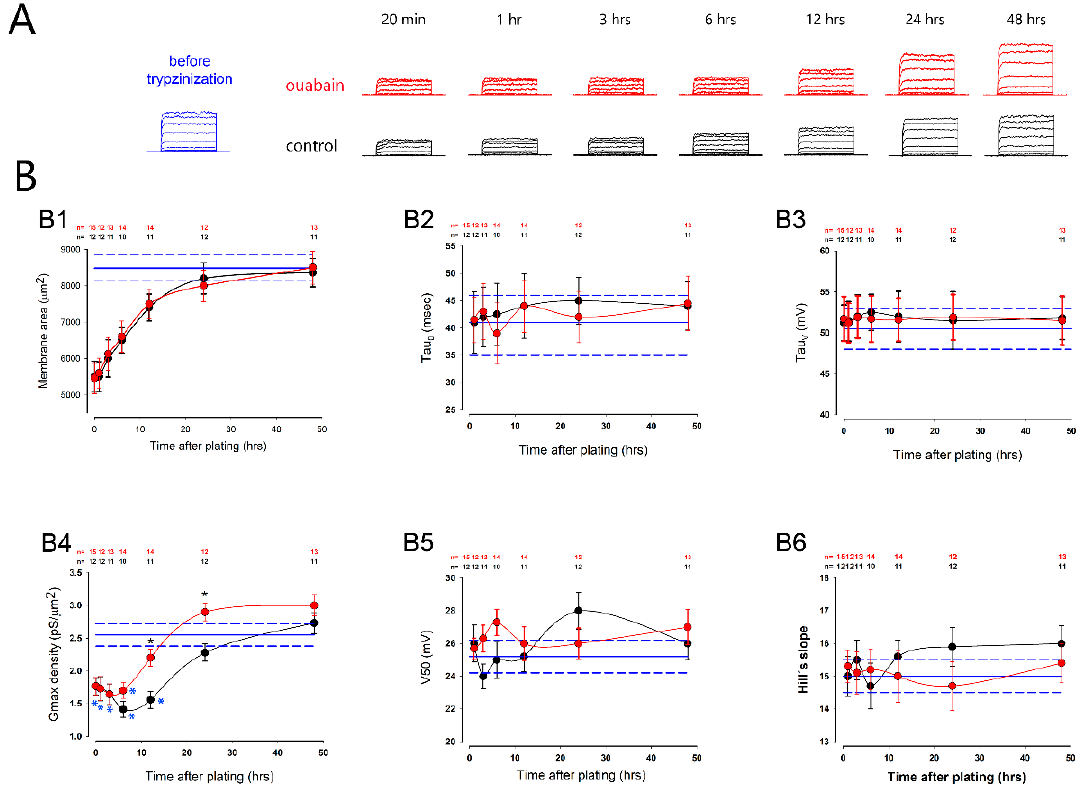
Figure 3. Ouabain accelerated the recovery of potassium currents after trypsinization. ( A ) The series of representative currents, recorded at different times after trypsinization and re-seeding at conflu- ence. At the top, in red, are shown the series of currents recorded from the cells treated with ouabain. At the bottom, in black, are shown the series of currents without treatment with ouabain. The series shown on the left in blue corresponds to a series of currents recorded from a cell in a mature mon- olayer, before trypsinization. ( B ) Graphs ( B1 – B6 ) compare the average values (±SE) of the ( B1 ) mem- brane surface, ( B2 ) τ 0 , ( B3 ) τ v , ( B4 ) density of gmax, ( B5 ) V 50 and ( B6 ) Hill’s slope. In all these graphs, the red circles correspond to cells treated with ouabain and the black ones, to untreated cells. The blue lines show the corresponding values obtained from cells before trypsinization. Black asterisks indicate a statistically significant difference between the control and ouabain-treated groups for each time. Blue asterisks denote a statistically significant difference as compared to the mean value before trypsinization ( blue lines ). The numbers at the top of the graphs indicate the number of repe- titions. (*) denotes p < 0.05. As shown in graph B1, the membrane area was significantly reduced after trypsini- zation, but gradually recovered until it reached its initial value after 12 h; ouabain did not influence this process nor did it influence the speed of activation of currents. As shown in graphs B2 and B3, the values of τ 0 and τ v were not statistically different between the con- trol groups and those treated with ouabain, or in the case of V 50 and Hs. However, trypsinization did significantly affect the maximum conductance density ( δ G max ), as shown in Figure 3(B4). In both, untreated and ouabain-treated cells, the δ G max was significantly reduced compared to the average value of cells before trypsinization ( blue asterisks ); nonetheless, this parameter gradually recovered such that after a given time, it was no longer statistically different from the value it had before trypsinization ( blue horizontal lines ). In the case of cells not treated with ouabain, the δ G max ceased to be significantly lower than that of cells before trypsinization, until 24 h after seeding, while in cells treated with ouabain, this time was reduced to 12 h. Considering the δ G max is an estimate of the density of K + channels in the membrane, these results might suggest that ouabain favors a faster recovery of K + channels that were lost in the process of trypsinization. 2.4. Ouabain Did Not Produce Changes to Potassium Currents in Subconfluent Cells